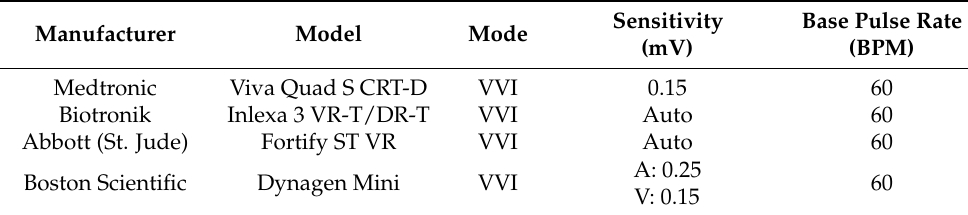
Table 2. List of tested ICDs with the specific models and programmed parameters. Manufacturer